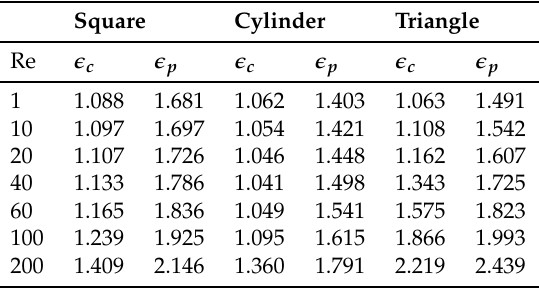
Table A2. Normalized mass transfer and normalized pressure drop for all active spacer-filled channels with respect to the corresponding values for flat channel at T = 20 ◦ C.